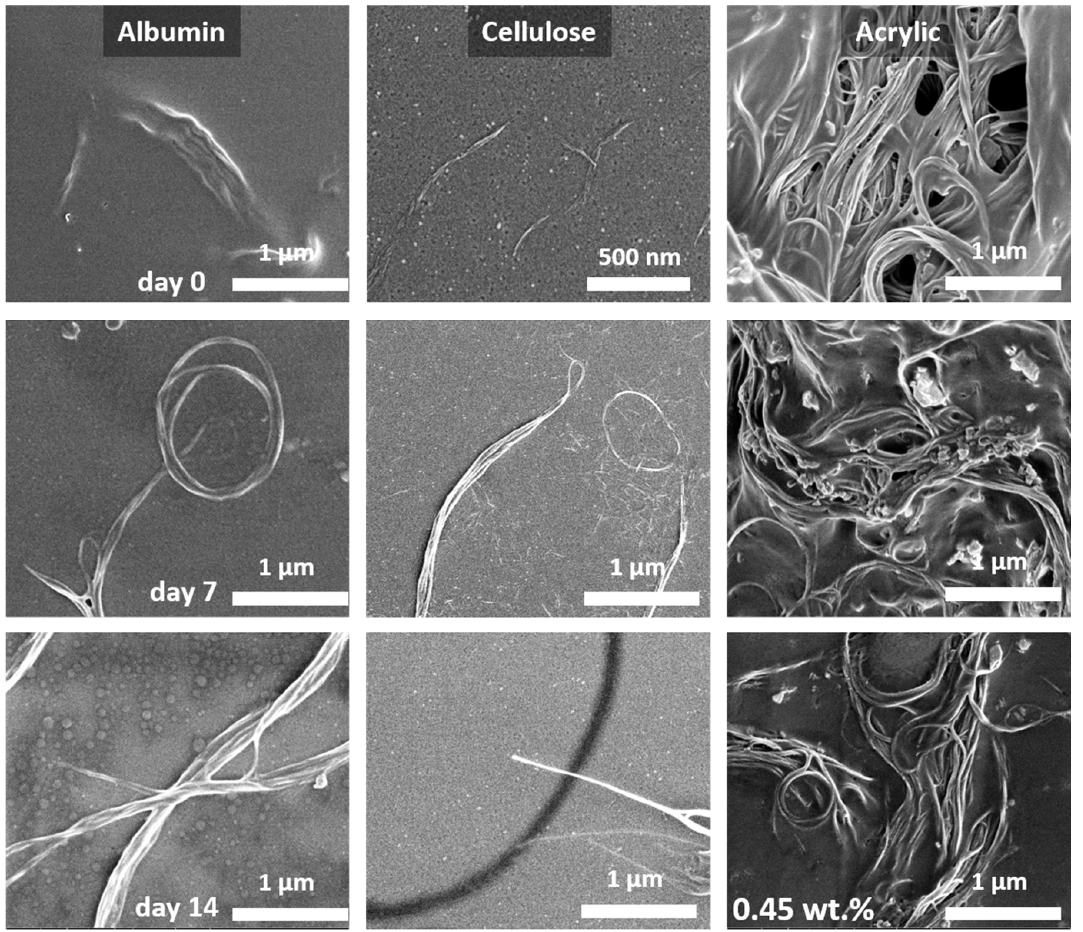
Figure 2. Scanning electron micrographs of Si / SiO 2 samples with composites of albumin (first column), carboxymethylcellulose (second column), and acrylic polymer (third column) mixed with 0.45